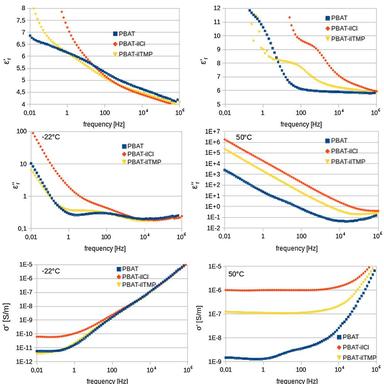
Relative dielectric permittivity (top), loss (middle) and real conductivity (bottom) versus frequency, at −22 °C (left) evidencing the relaxation around 100 Hz and at 50 °C (right) showing conduction and the relaxtion. The latter corresponds to the conductivity step around 100 Hz for PBAT, and is overlapped by the conduction for the other blends (It corresponds anyway to the steps in r and could be fitted properly).